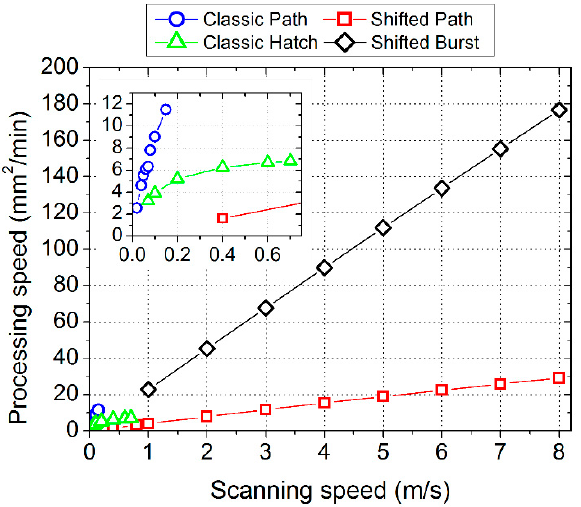
Figure 11. Processing speed calculated for different laser scanning speeds and for different laser texturing methods (scanning strategies). The data are based on the processing time calculated by the scanning software for the processed area of 2.4 × 170 mm 2 .